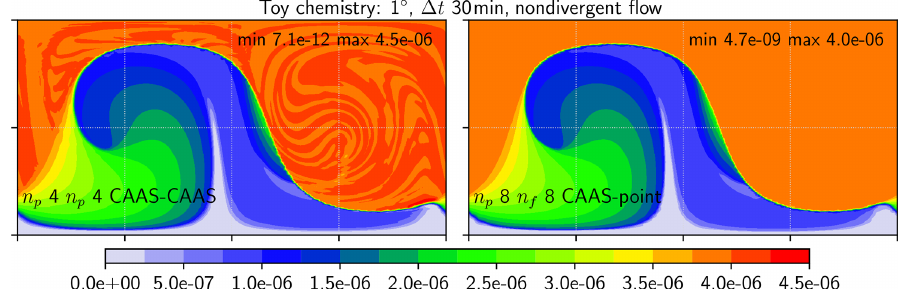
Figure 17. Images of the monatomic tracer at the end of the first cycle. Text at the lower left of each image states the configuration. Text at the upper right reports global extremal values.